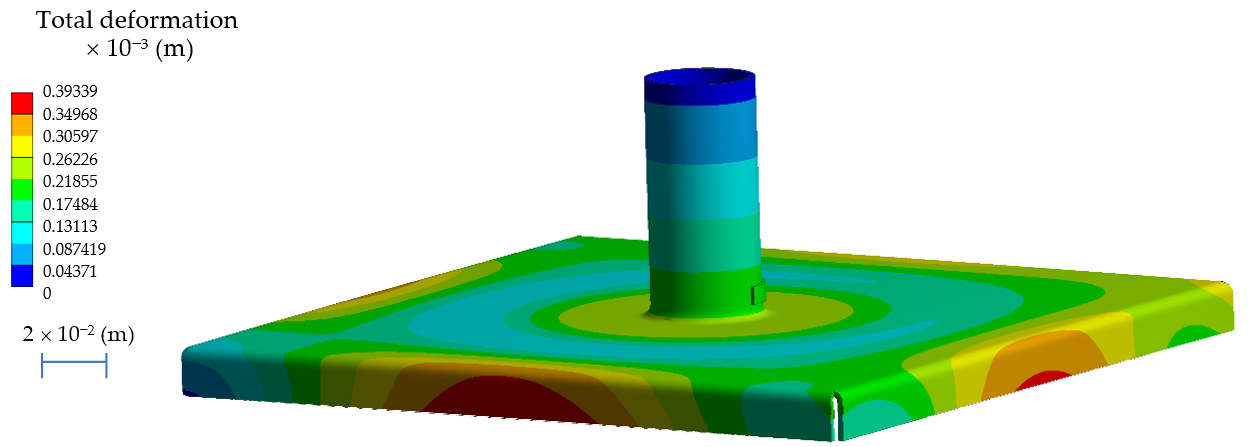
Figure 12. The state of deviation after the h6 flange extrusion process and stub